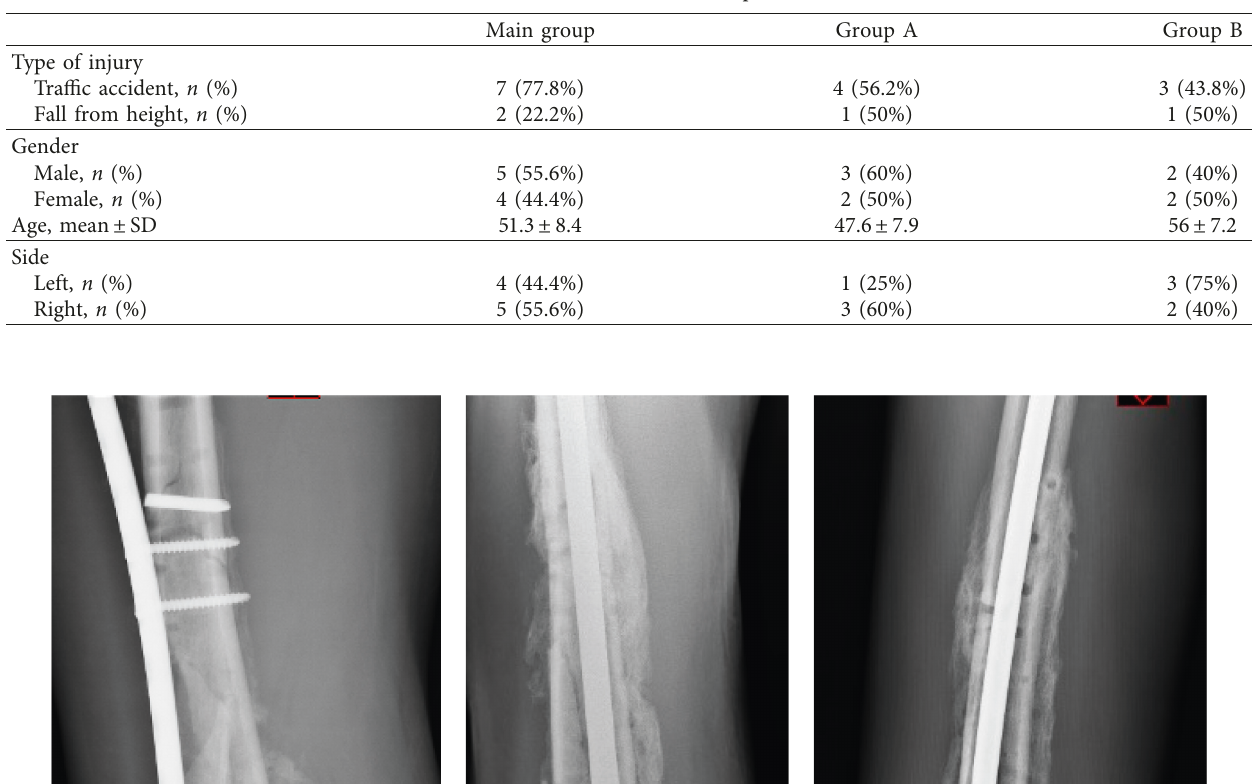
Table 1: Characteristics of the sample ( n � 9).